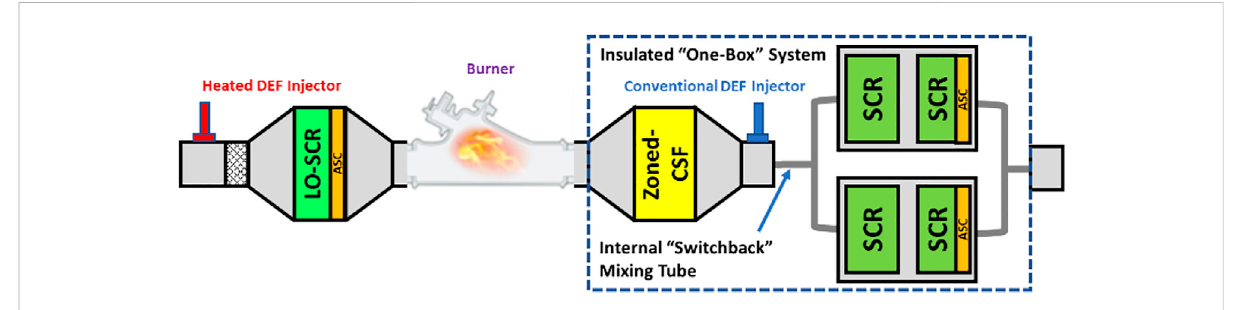
FIGURE 3 Burner con fi guration schematic for the CDA + LO-SCR + Burner + Primary